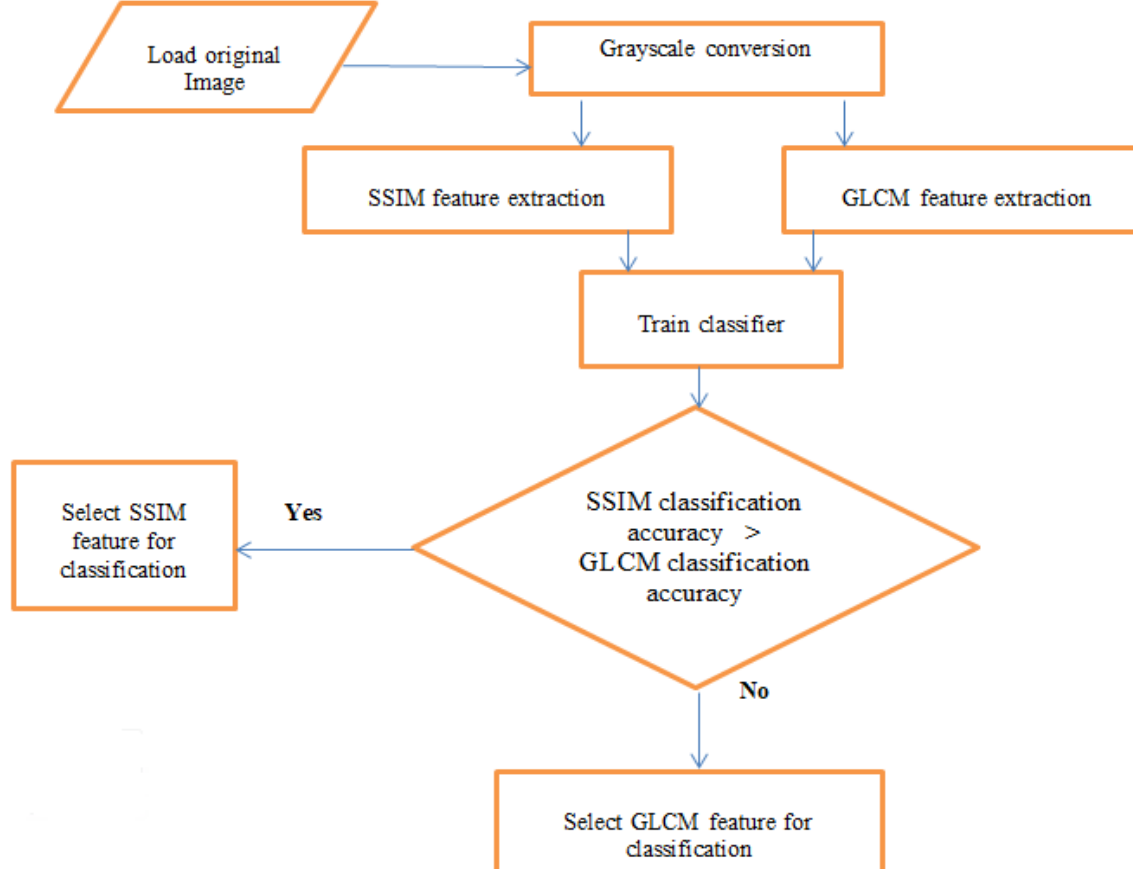
Fig.3: Flowchart of the Methodology adopted for selecting Image Classification Features